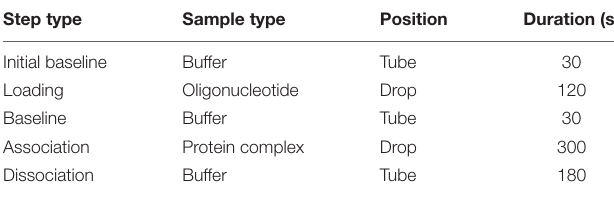
TABLE 1 | BLI measuring protocol for Cascade-dsDNA